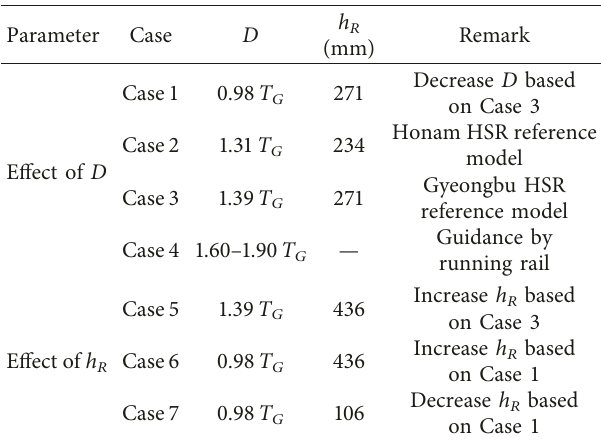
Figure 4: Geometric conditions of the containment wall on the railway bridge in Table 3: Geometric condition of the track. Table 4: Analysis cases.